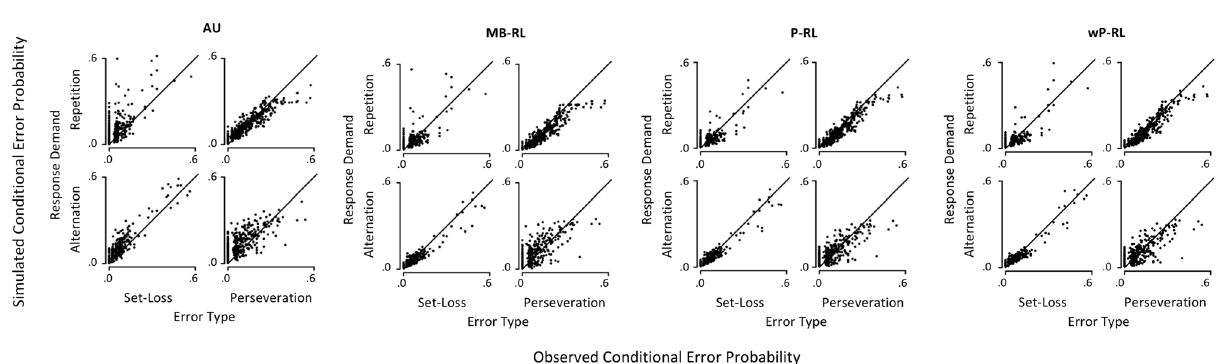
Figure 3. Observed (left plot) and simulated group mean conditional error probabilities (all other plots). Error bars indicate ± 1 standard error of the mean. Note that set-loss and perseveration errors follow positive and negative feedback, respectively. AU attentional-updating model, MB-RL only model-based reinforcement- learning model, P-RL parallel reinforcement-learning model, wP-RL weighted parallel reinforcement-learning model, SLE set-loss error, PE perseveration error, Repetition demanded response repetition, Alternation demanded response alternation, Conditional error probability probability of an error given error type (perseveration vs. set-loss) and response demand (repetition vs. alternation).